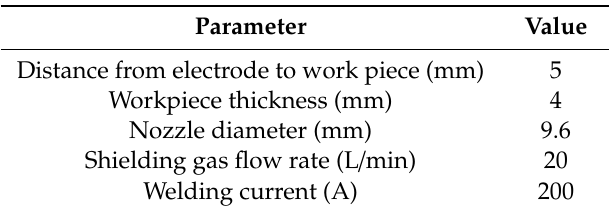
Table 2. Main welding parameters.